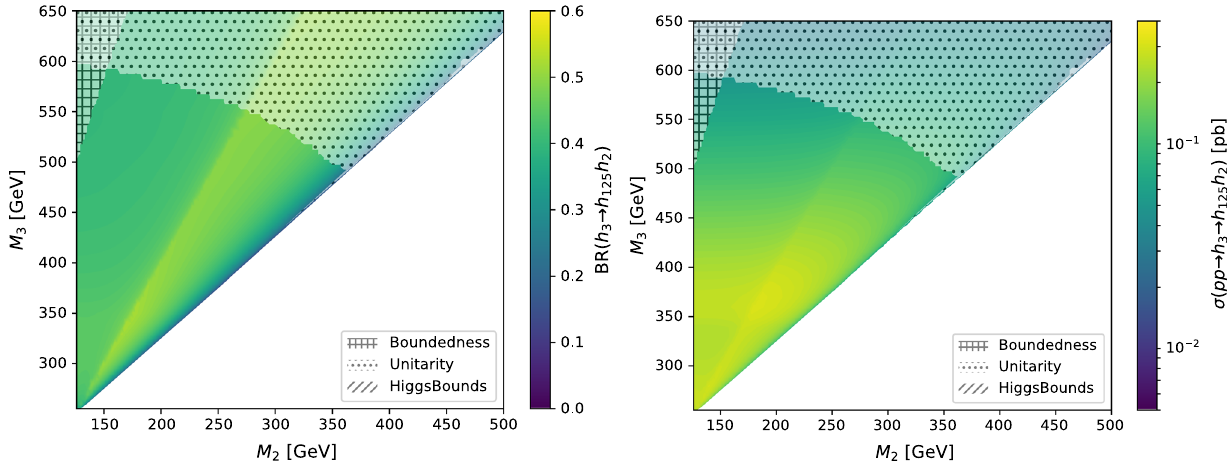
Fig. 9 Benchmark plane BP3 for the decay signature h 3 → h 125 h 2 with h 125 ≡ h 1 , defined in the ( M 2 , M 3 ) plane. The color code shows BR ( h 3 → h 125 h 2 ) (left panel) and the signal rate for pp → h 3 →